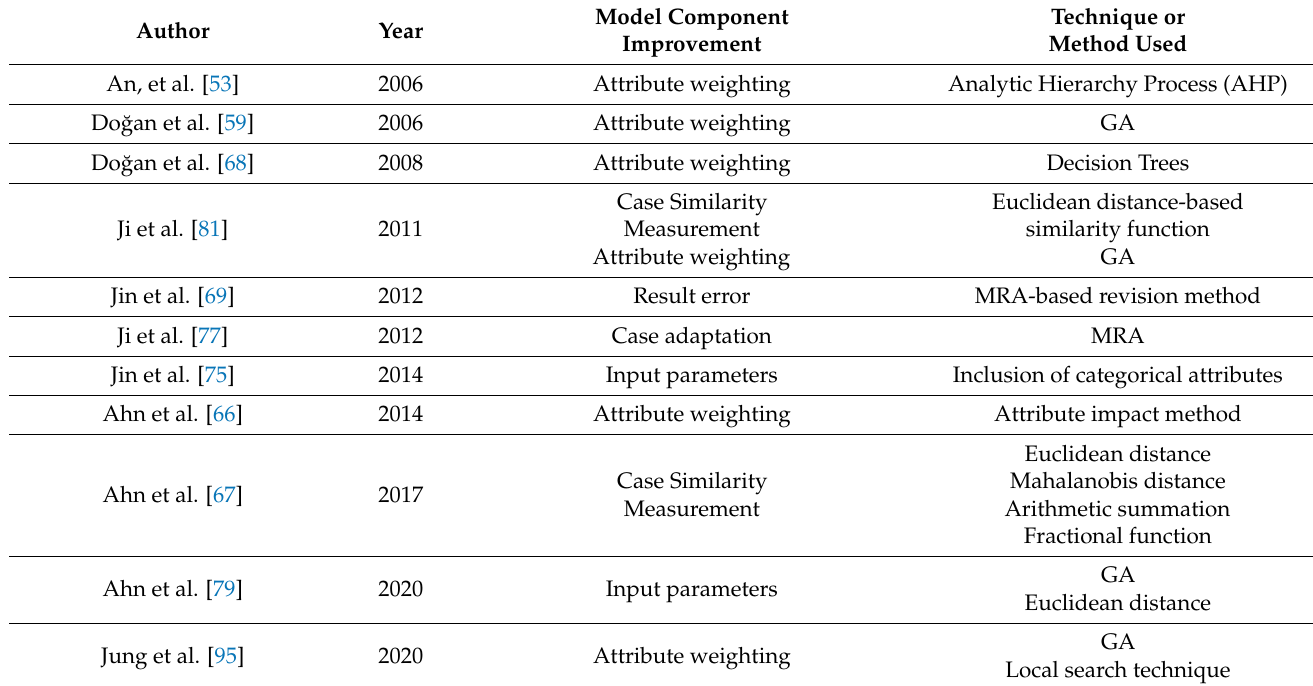
Table 6. Improvements on CBR models from